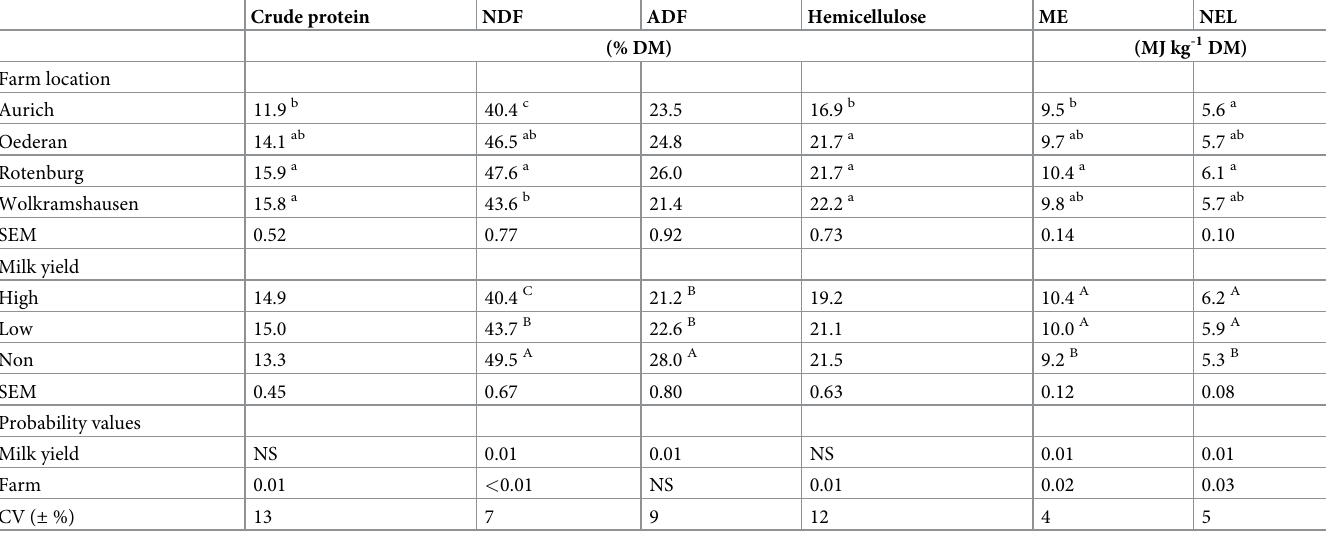
SEM = standard error of mean; CV = mean coefficient of variation between replicate farms (n = 4); different lowercase superscript letters within a column indicate a significant difference between the farms ( P < 0.05, Holm-Sidak test); different uppercase superscript letters within a column indicate a significant difference between the milk yield groups ( P < 0.05, Holm-Sidak